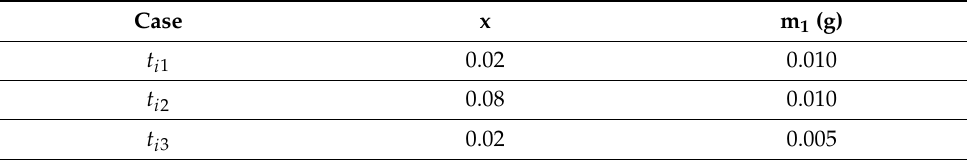
Figure 14. Average values of time to ignition t i as a function of airflow velocity U for tests with Lower Ignition Propensity (LIP), No Lower Ignition Propensity (N/LIP) and butts compared with the model predictions of t i (Equation (39)), for the parameters given in Table 8. Table 8. Model parameters used in the cases illustrated in Figure